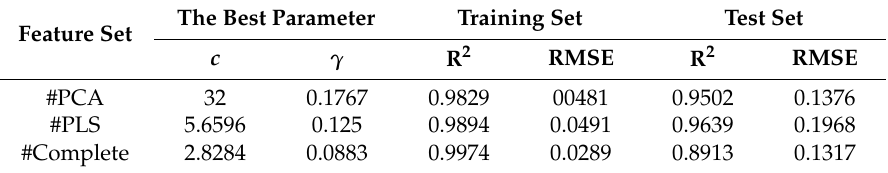
Table 3. Comparison of the #PCA, #PLS, and #Complete parameters combined with the SVM model.